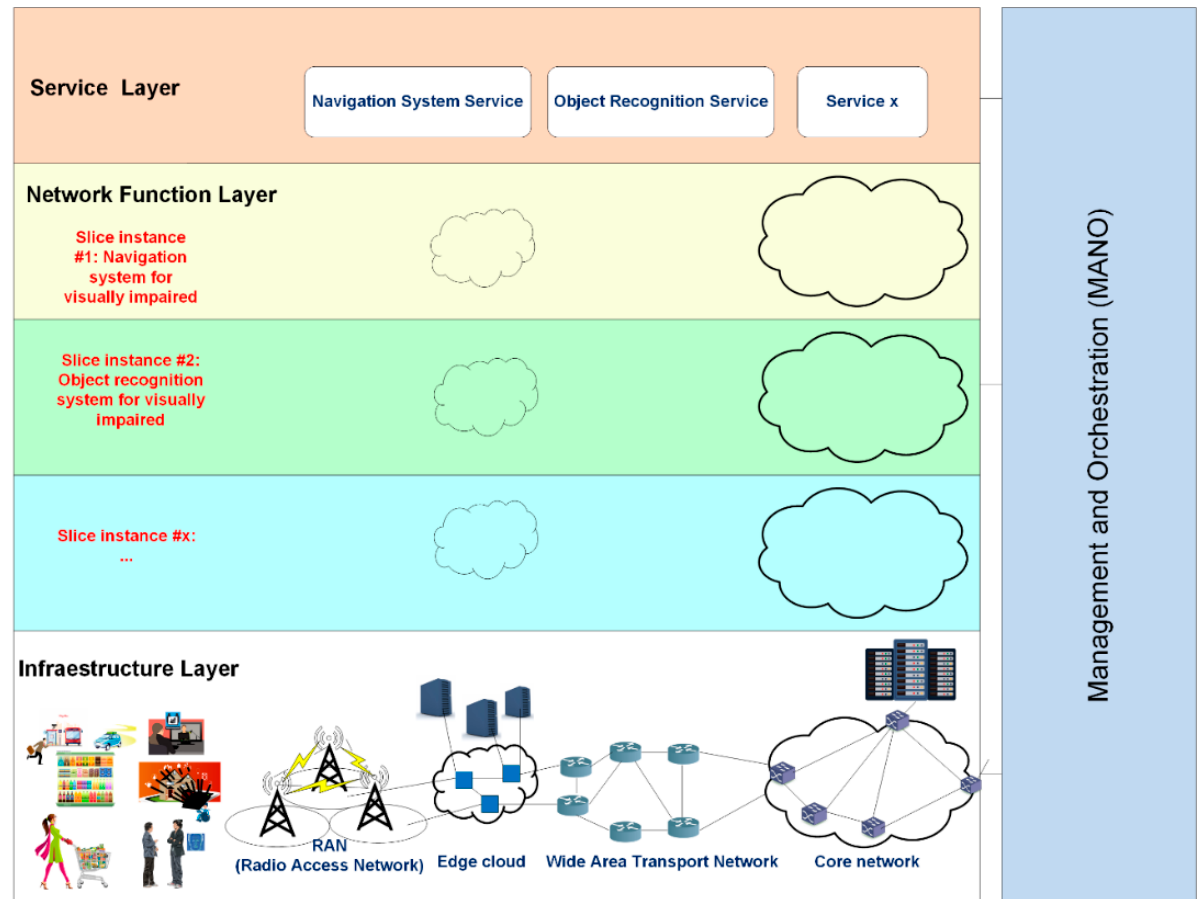
Figure 6. Network slicing architecture for people with